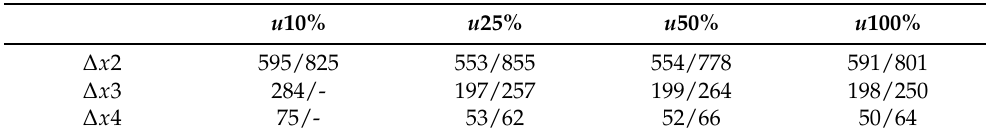
Table 2. The simulation cost metric, N h . For each ∆ x and u % combination, two values are given, corresponding to MULES and isoAdvector, respectively. u